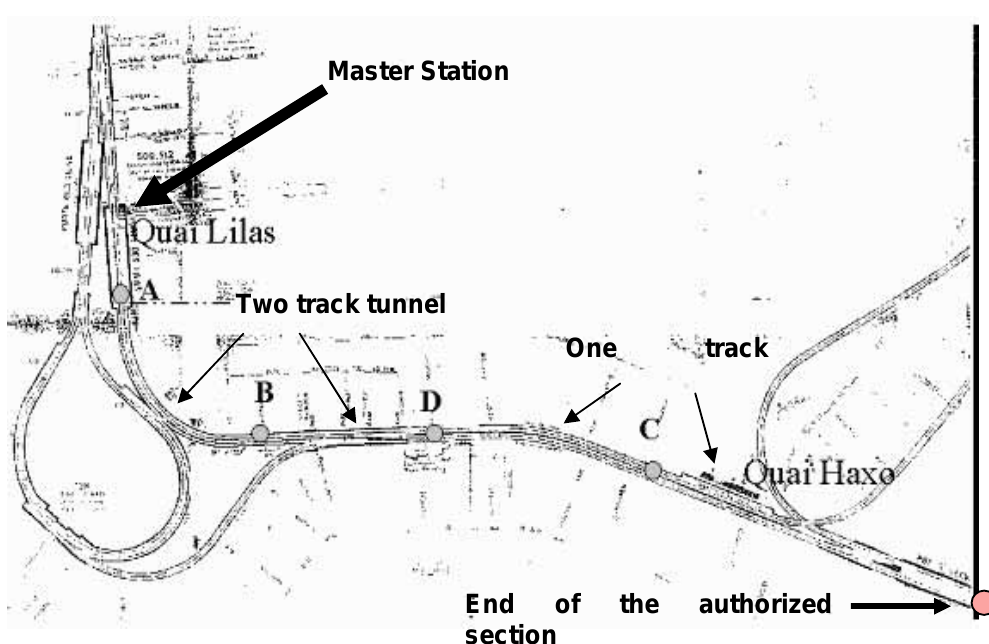
Figure 5. Configuration of the test line of the Paris